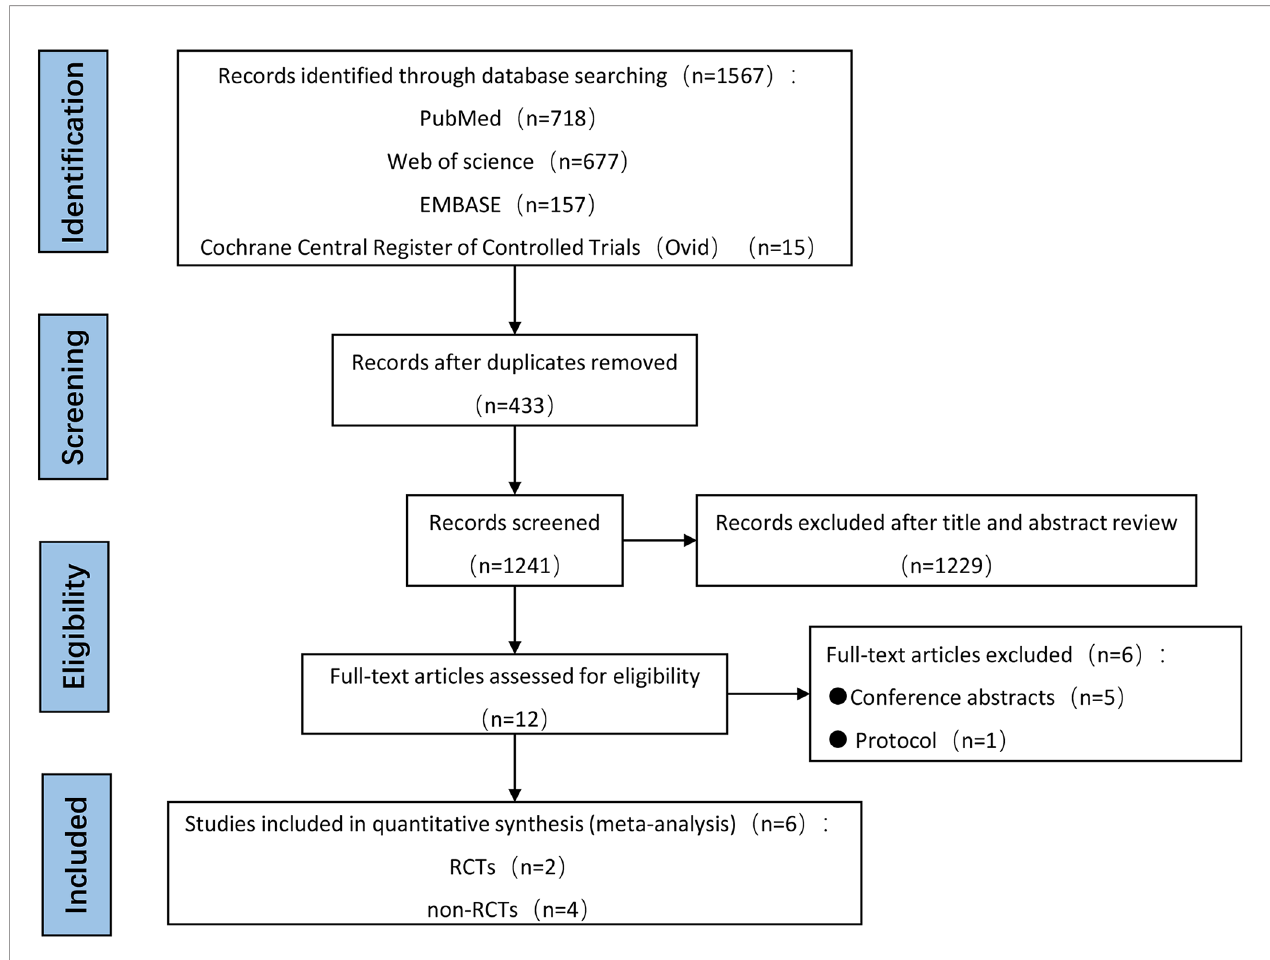
FIGURE 1 | PRISMA selection fl ow